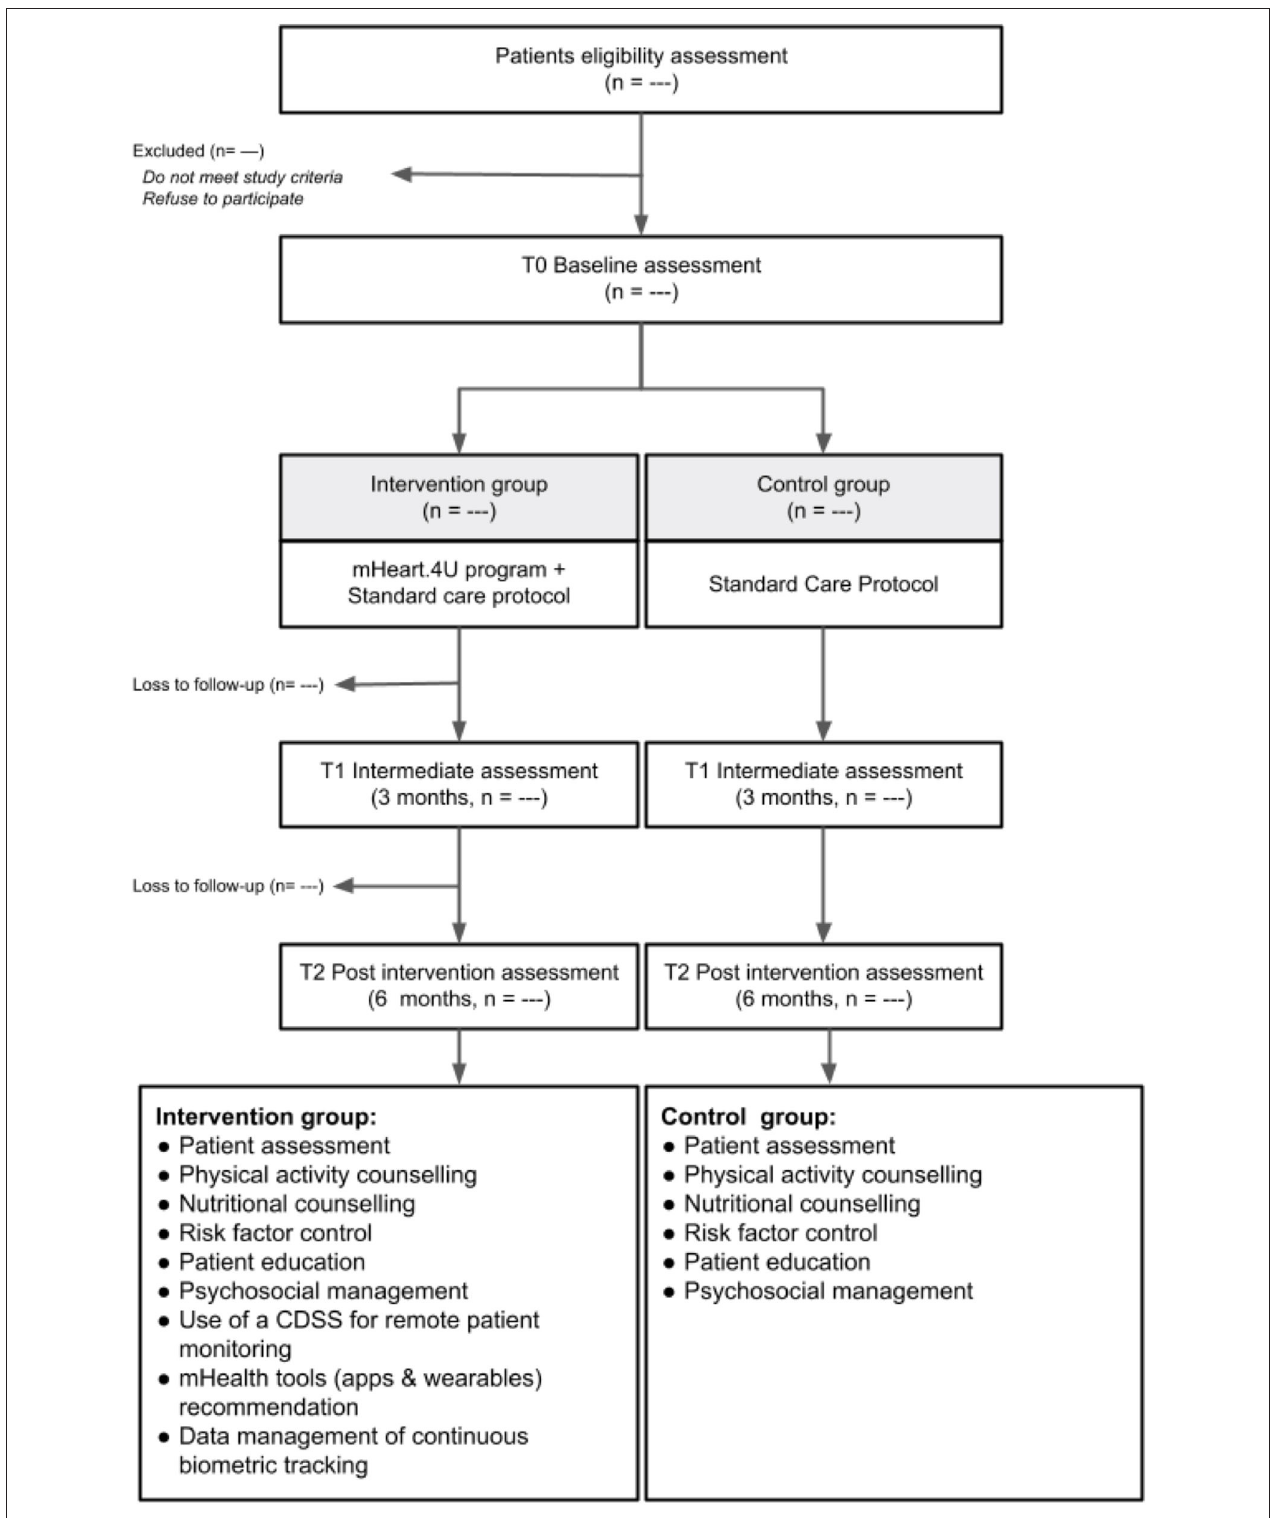
FIGURE 1 | Participant’s